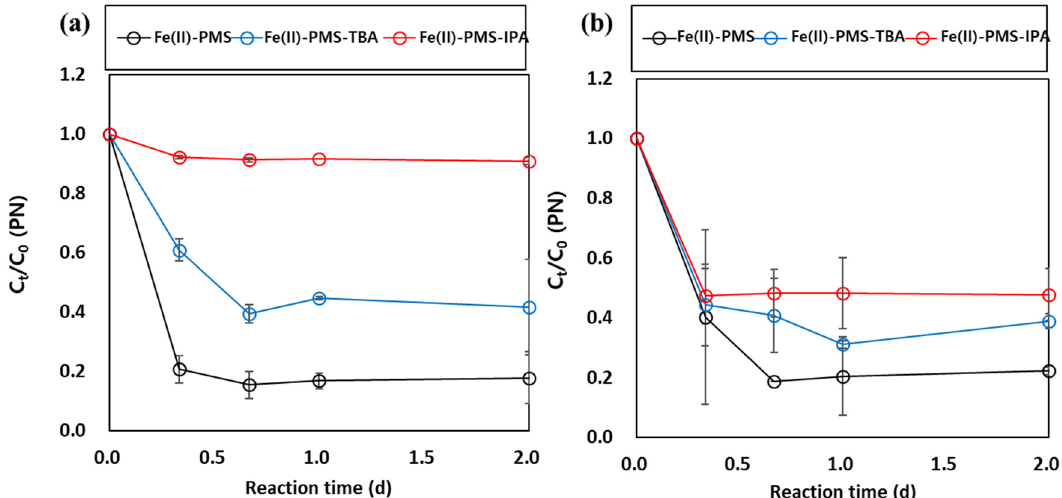
Figure 5. The quenching experiments in the absence/presence of borate buffer solution with Fe(II) ions as a catalyst ( a ) the absence of borate buffer solution and ( b ) the presence of borate buffer solution ([PN] = 20 µM, [PMS] = 200 µM, [borate buffer solution] = 18.75 mM, [pH] = 7.5~8.0, [TBA] = 100 mM, [IPA] = 100 mM, [Fe(II)SO 4 ] = 0.1 mM).